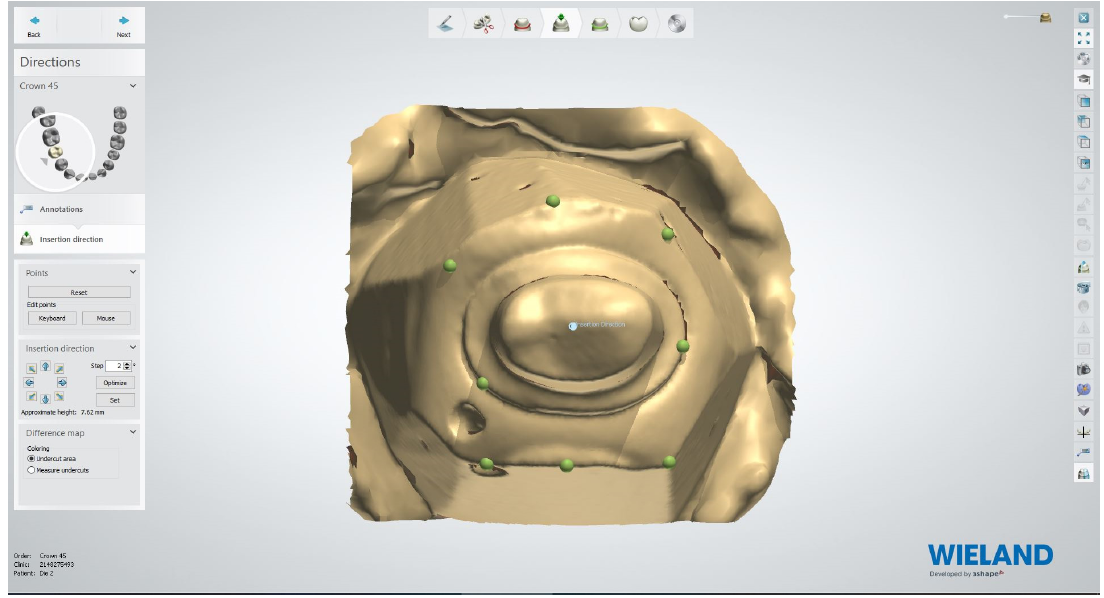
Figure 2. Designing in CAD software.